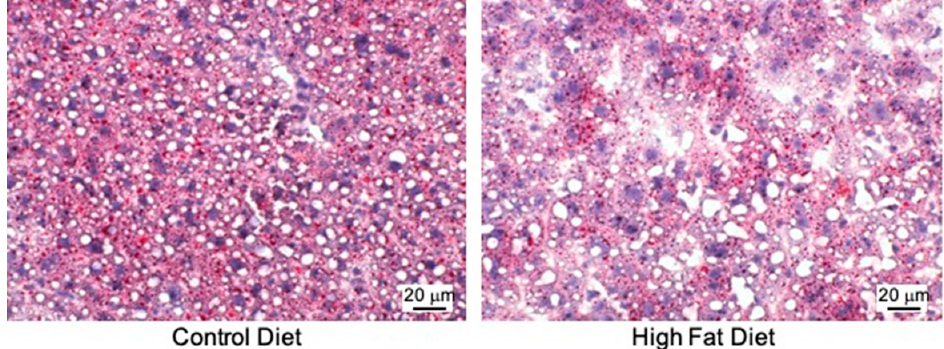
Figure 1. The effect of control and High ‐ Fat (HF) diets on food ( A ) and calories ( B ) intake, and on animal growth ( C ) and relative liver weights ( D ). Data shown are the mean ± SEM (n = 10 per group); * p < 0.05; ** p < 0.01 control versus HF. Oil Red O staining showed that livers from HF ‐ fed mice presented more macrovesic ‐ ular lipid droplets of Oil Red O positive staining than controls (Figure 2). Ballooned hepatocytes and sinusoids capillarization, on the other hand, were also exacerbated in the HF ‐ fed mice, showing more inflated hepatocytes, as compared to the control mice, indi ‐ cating liver damage by the HF diet. This finding is consistent with a previous study, in which hepatic fat accumulation was reported in apoE − / − mice after seven weeks of a diet containing similar amounts of fat and cholesterol as the HF ‐ diet used in this study [41].